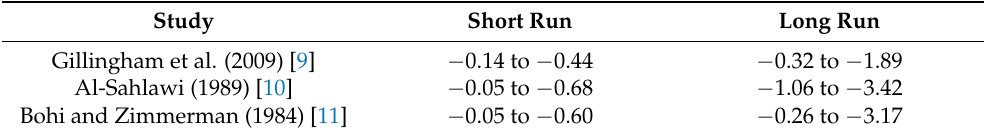
Table 1. Selected surveys on own-price elasticity estimates of residential natural gas demand. Study Short Run Long